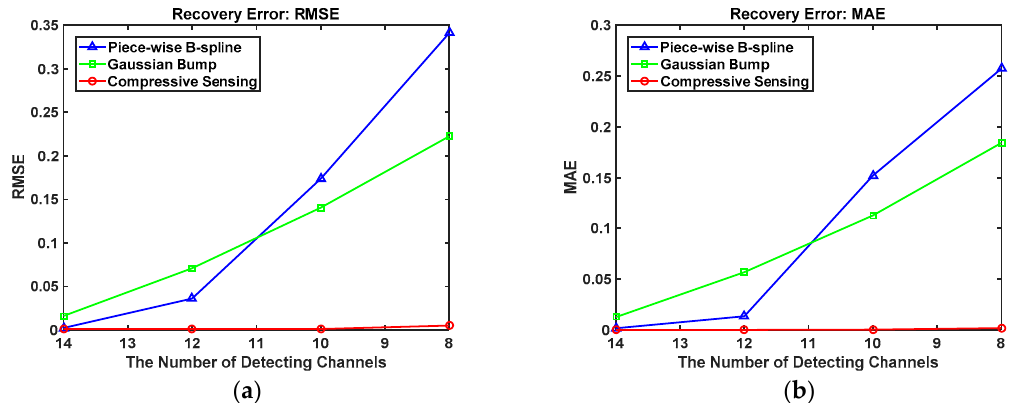
Figure 8. The Triple-peak spectrum recovery error with three different spectrum unfolding methods as the measurements decrease. ( a ) RMSE; ( b ) MAE.